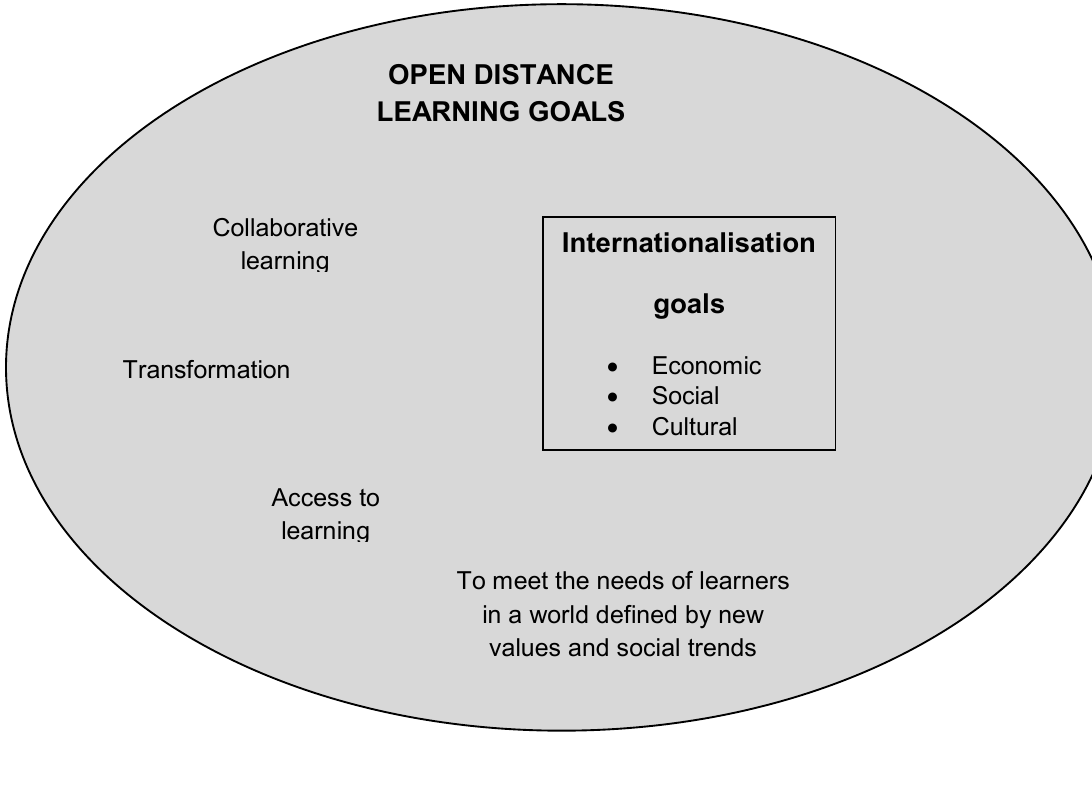
Figure 1 . Internationalisation goals as a subset of ODL